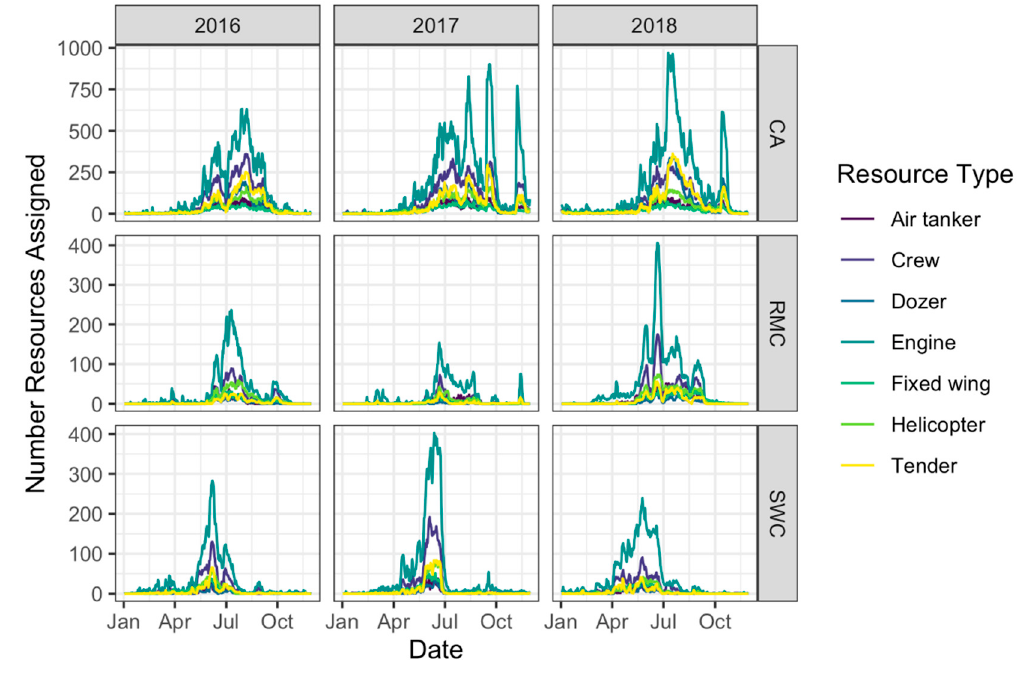
Figure A2. Daily number of resources assigned to all fires in the three GACCs from 2016 to 2018.